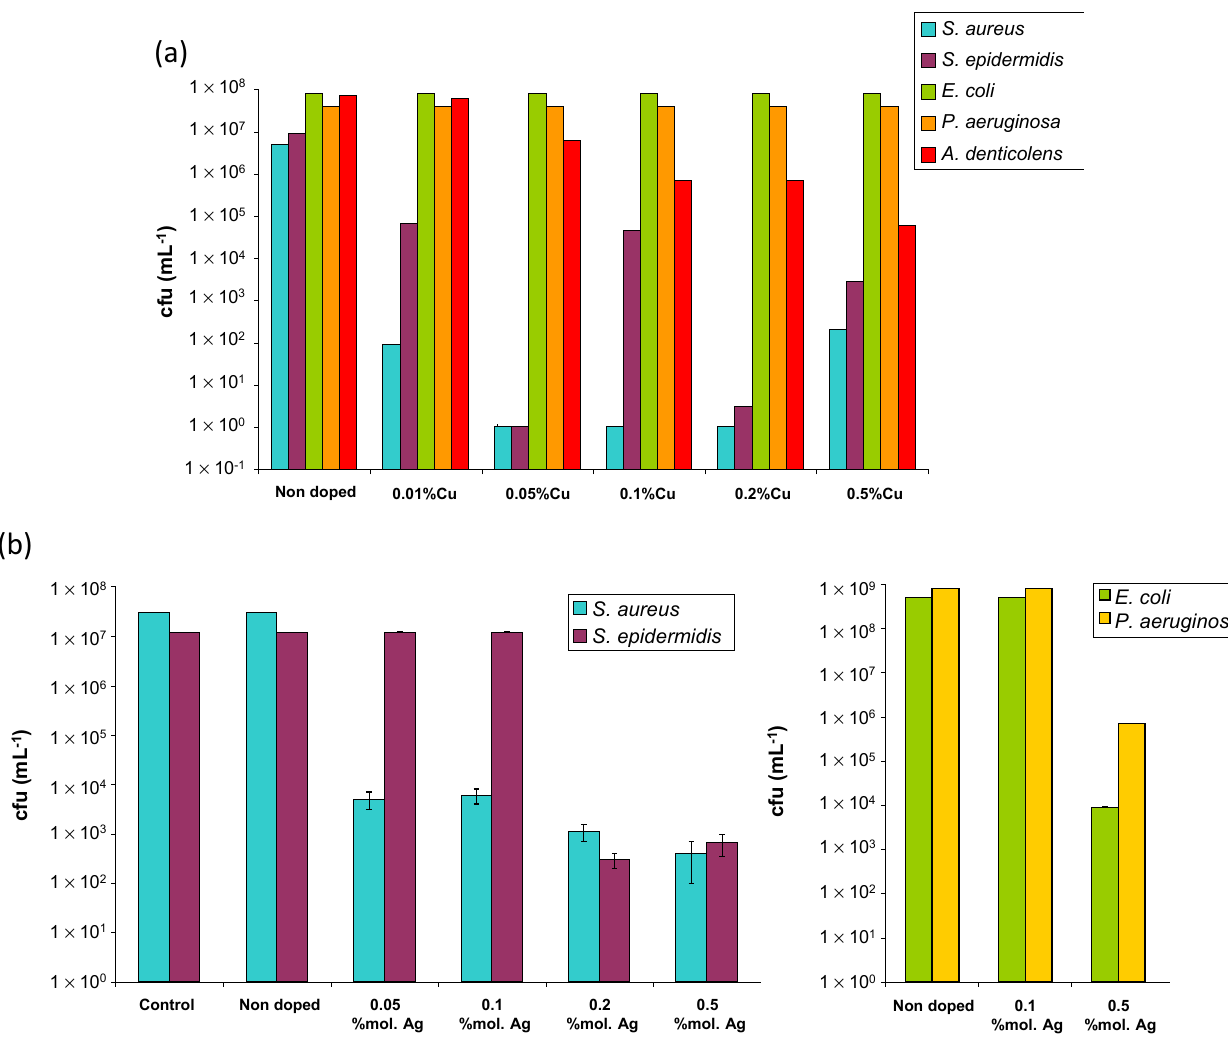
Figure 8. Antibacterial results of pre-equilibrated hap-1d pelletized samples, non-doped (reference) or doped with Cu 2+ ( a ) or Ag + ( b ) ions, versus different Gram-positive ( S. aureus , S. epidermidis , and A. denticolens ) or Gram-negative ( E. coli and P. aeruginosa ) bacteria, after 24 h of contact.